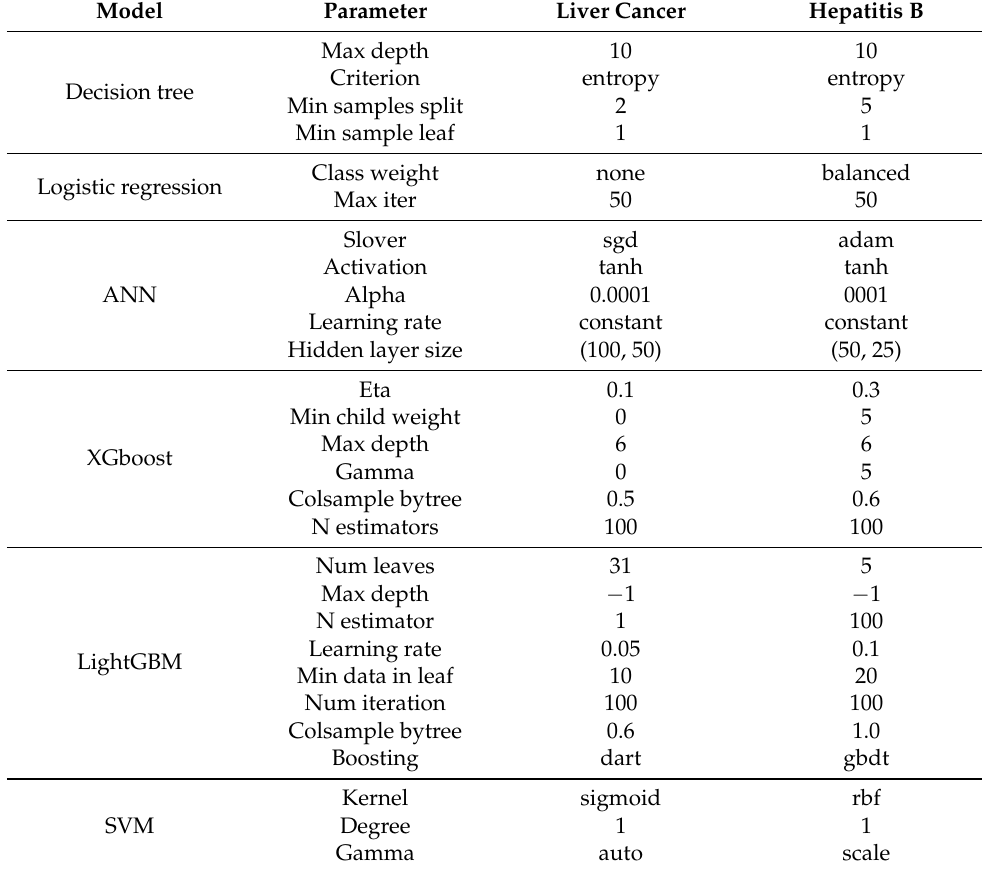
Table 3. List of optimized hyperparameters for the comparative